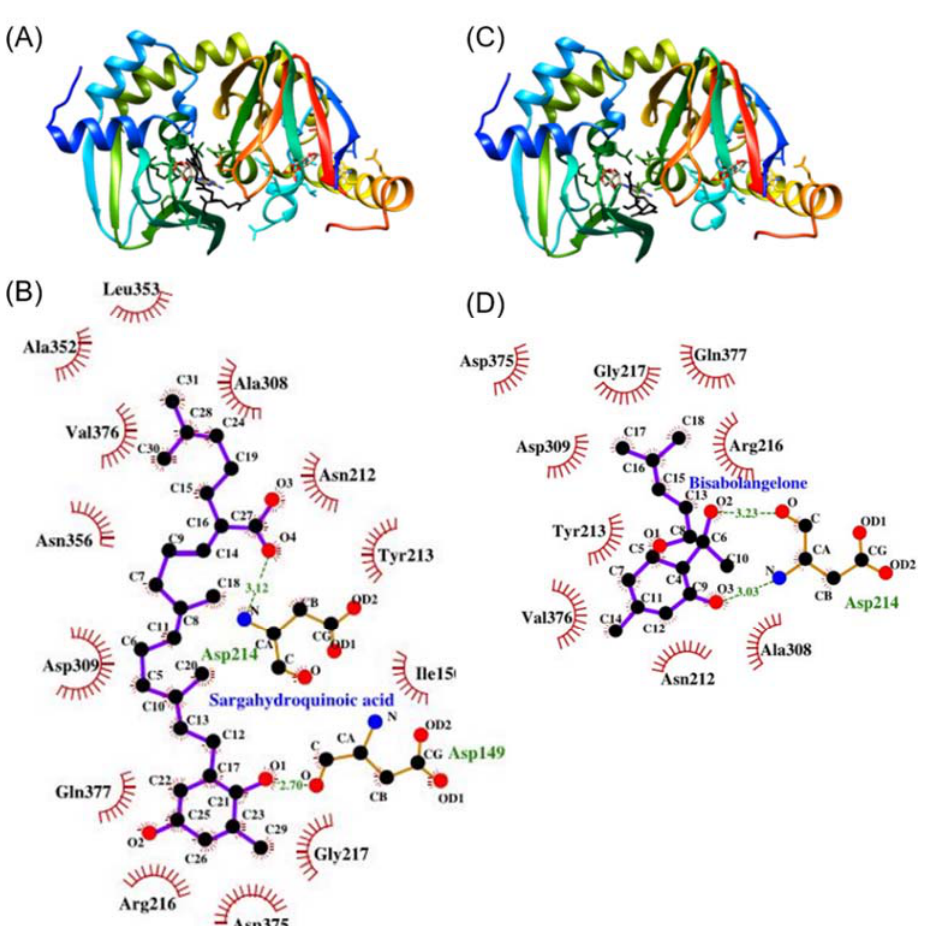
Figure 4. Protein-ligand docking simulation of SHQA to the cAMP binding domain of PKA. ( A ) Docking simulation of SHQA to the regulatory subunit II β of PKA. cAMP and SHQA are shown in the gray and black colors, respectively. ( B ) Binding mode analysis between SHQA and PKA (RII β ). ( C ) Docking simulation of BISA and the regulatory subunit II β of PKA. ( D ) Binding mode analysis between BISA and PKA (RII β ).